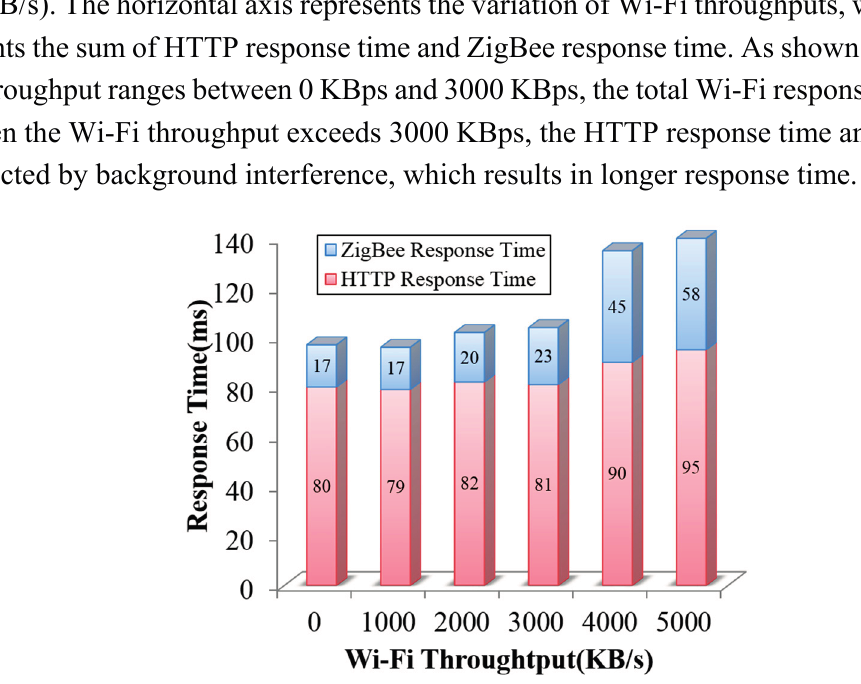
Figure 15. The impact of Wi-Fi throughput variation on the command execution response